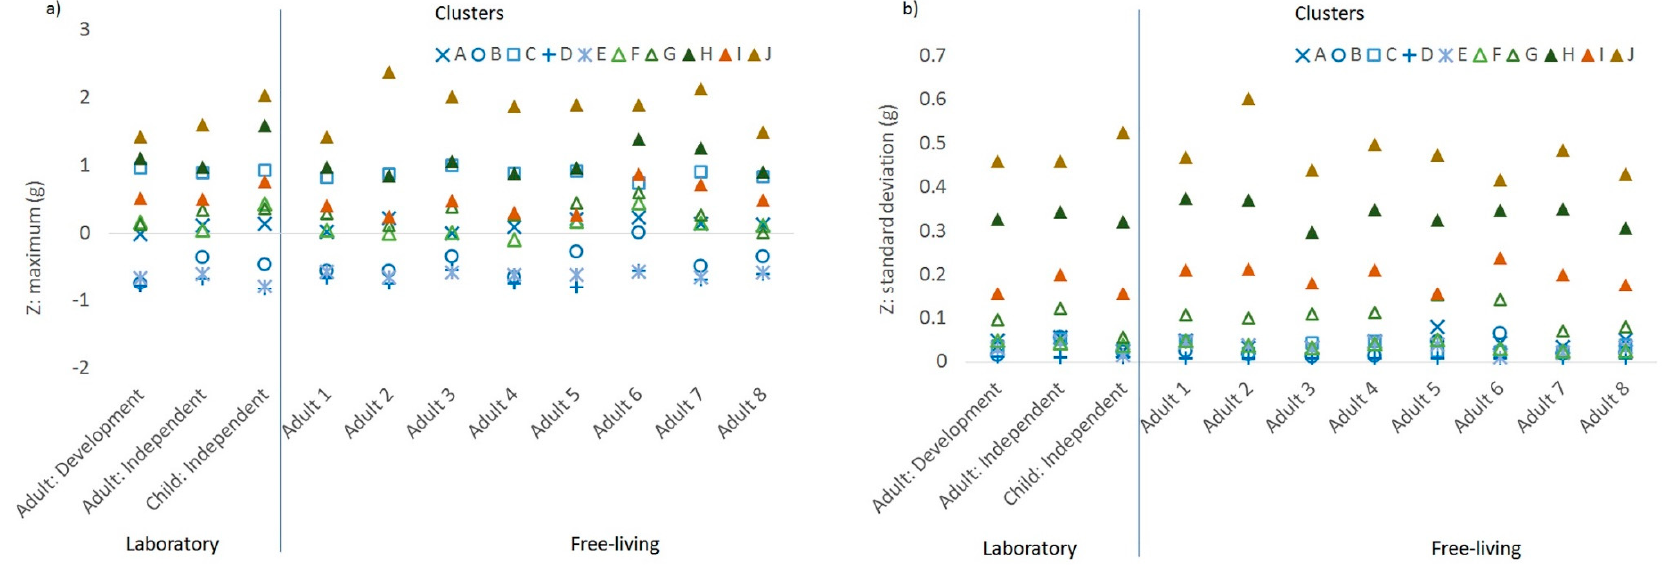
Figure 2. Characteristics of the acceleration features with the highest loadings by cluster and by sample, time domain: ( a ) maximum acceleration in the Z -axis and ( b ) standard deviation of acceleration in the Z -axis.